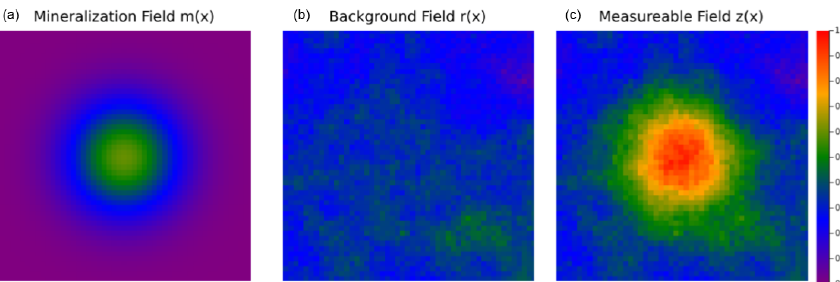
Figure 2. Two-dimensional exploration problem. The mineralization field m(x) (a) and the background field r(x) (b) are summed to create the measurable field z(x) (c) .